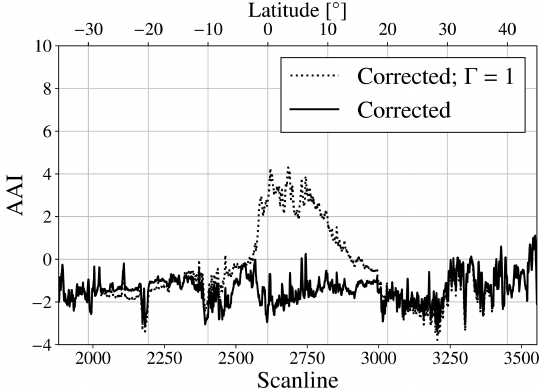
Figure 18. The AAI in pixel row 6 in orbit 11404, 26 December 2019. The latitudes in the scan lines are indicated at the top. The solid line is the result after the solar irradiance correction, and the dotted line is the result after the solar irradiance correction when solid limb darkening is not taken into account ( (cid:48) =